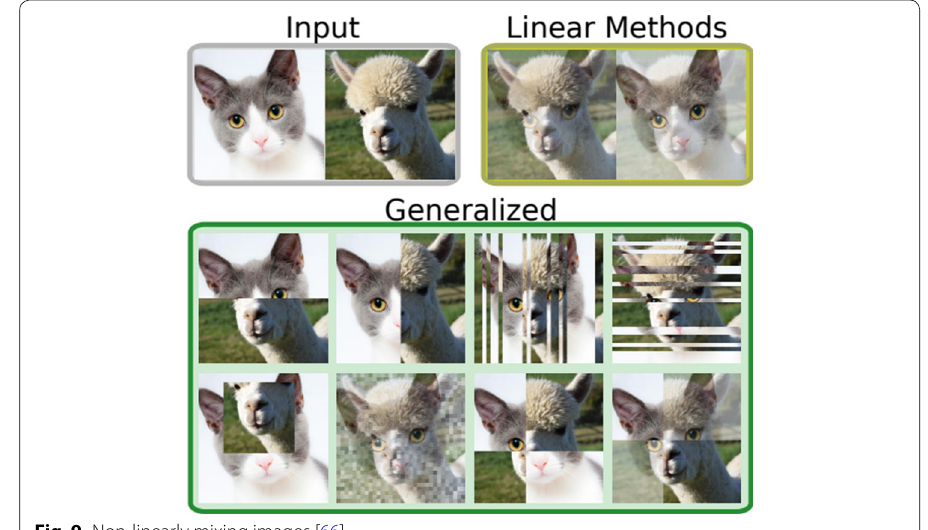
Fig. 9 Non-linearly mixing images [66]